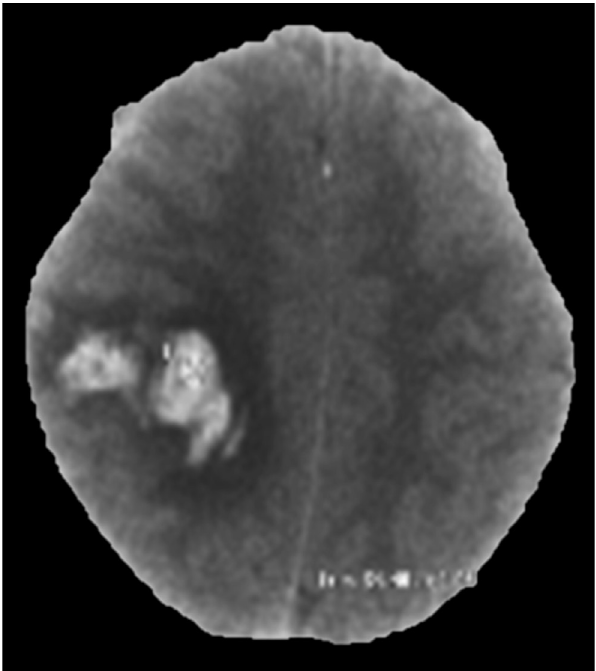
Figure 1. CT scan head showing a right high parietal hemorrhagic infarct with surrounding edema.